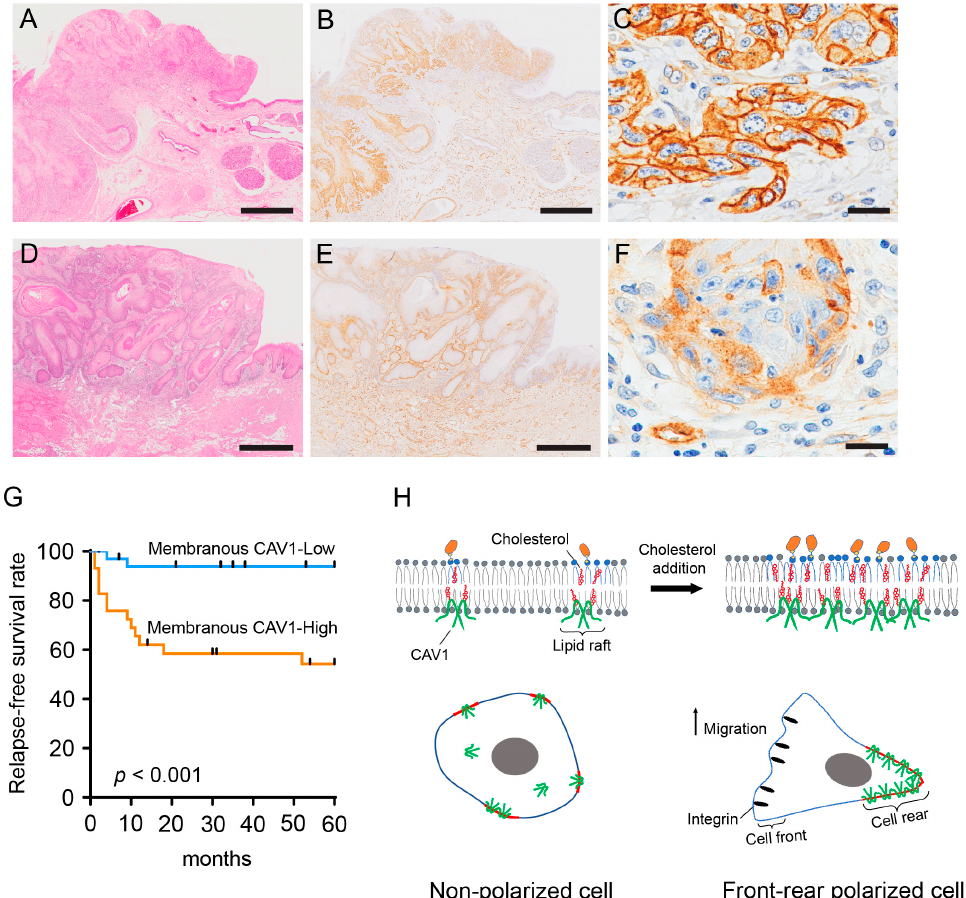
Figure 5. Membranous CAV1 expression in oral squamous cell carcinoma (OSCC) tissue and its correlation with relapse-free survival. ( A – C ) Representative photomicrograph of the tumor with high membranous CAV1 expression (21%). ( D – F ) Representative photomicrograph of the tumor with low membranous CAV1 expression (6%). ( A , D ) H&E staining. ( B , C , E , F ) Immunostaining for CAV1. ( C ) and ( F ) are higher-magnification images of ( B , E ), respectively. Scale bars, 1 mm ( A , B , D , E ) and 20 µm ( C , F ). ( G ) Kaplan–Meier curve showing relapse-free survival of OSCC patients based on membranous CAV1 expression. High membranous CAV1 expression is significantly associated with poor relapse-free survival ( p < 0.001). ( H ) Schematic diagram showing the conclusions of this study. Cholesterol addition increases the cholesterol level in the plasma membrane and the CAV1 level in the lipid raft. Meanwhile, the cell promotes cell migration by changing its shape from polygonal to fan-shaped; polarized morphology with trailing edge localization of